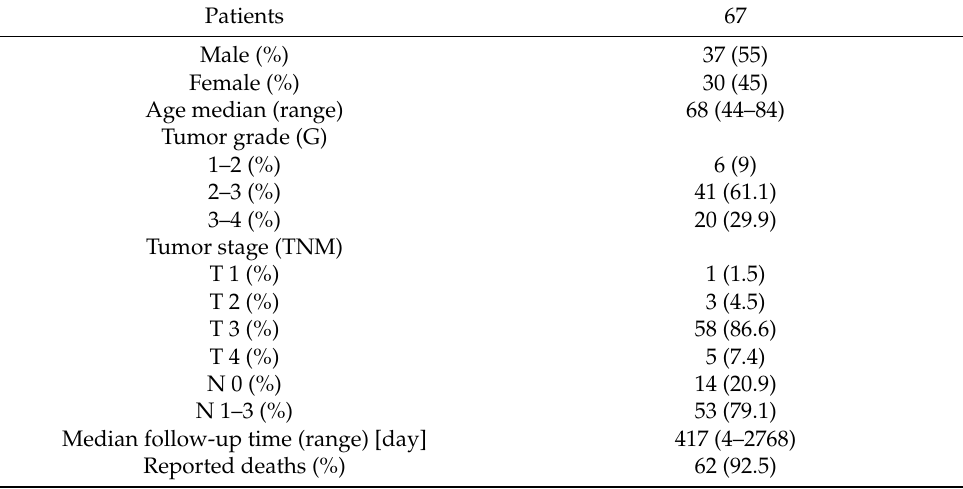
Table 1. Clinical data